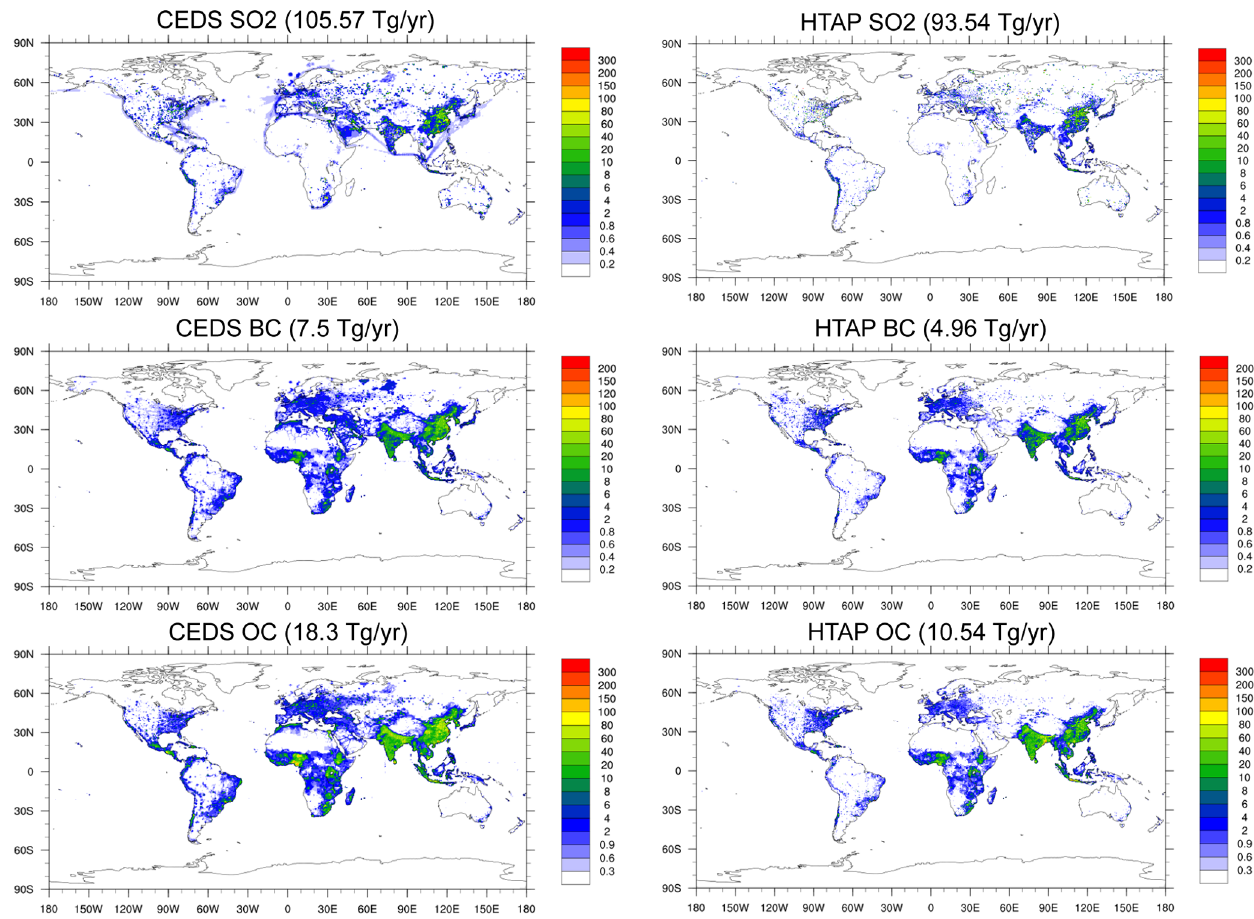
Figure 3. Anthropogenic emissions of CEDS (2014) and HTAP (2010) for SO 2 (molec.km − 2 h − 1 ), BC, and OC (ngm − 2 s − 1 ) in summer in